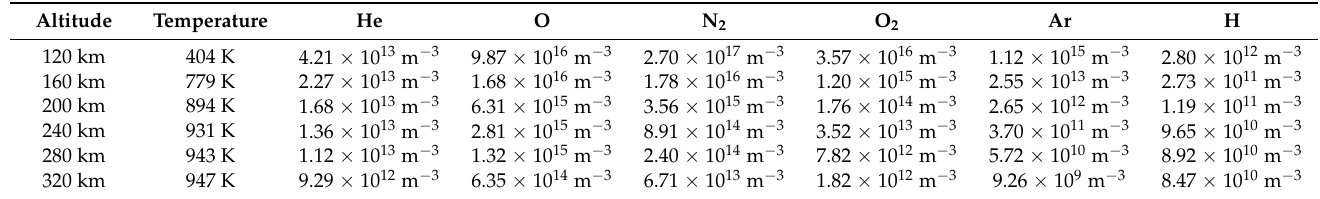
Table 7. Background atmospheric temperature and numerical density of various molecules at different altitudes under medium F10.7 and medium Ap environments (MM).